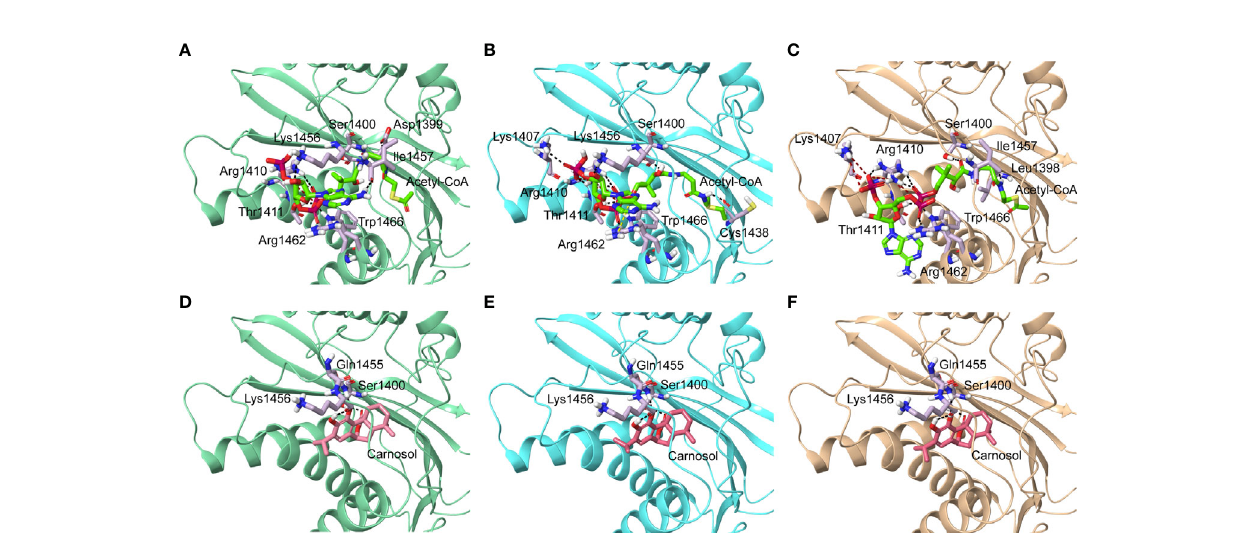
FIGURE 5 | Molecular docking of acetyl-CoA and carnosol in the active site of p300. Polar interactions of acetyl-CoA docked in the active site of the p300 in the structure with Protein Data Bank ID: (A) 4PZR, (B) 4PZS, and (C) 4PZT. Polar interactions of carnosol docked in the active site of the p300 in the structure with Protein Data Bank ID: (D) 4PZR, (E) 4PZS, and (F) 4PZT. The protein structure is shown in cartoon representation (4PZR in green, 4PZS in cyan, and 4PZT in brown), acetyl CoA is shown in green stick representation, and carnosol is shown in pink stick representation. Protein residues that interact with the docked ligand are shown in lilac stick representation. Hydrogen bonds are represented by black dashed lines. TABLE 2 | Summary of binding energy and residues that interacted with ligands docked to p300 HAT. PDB